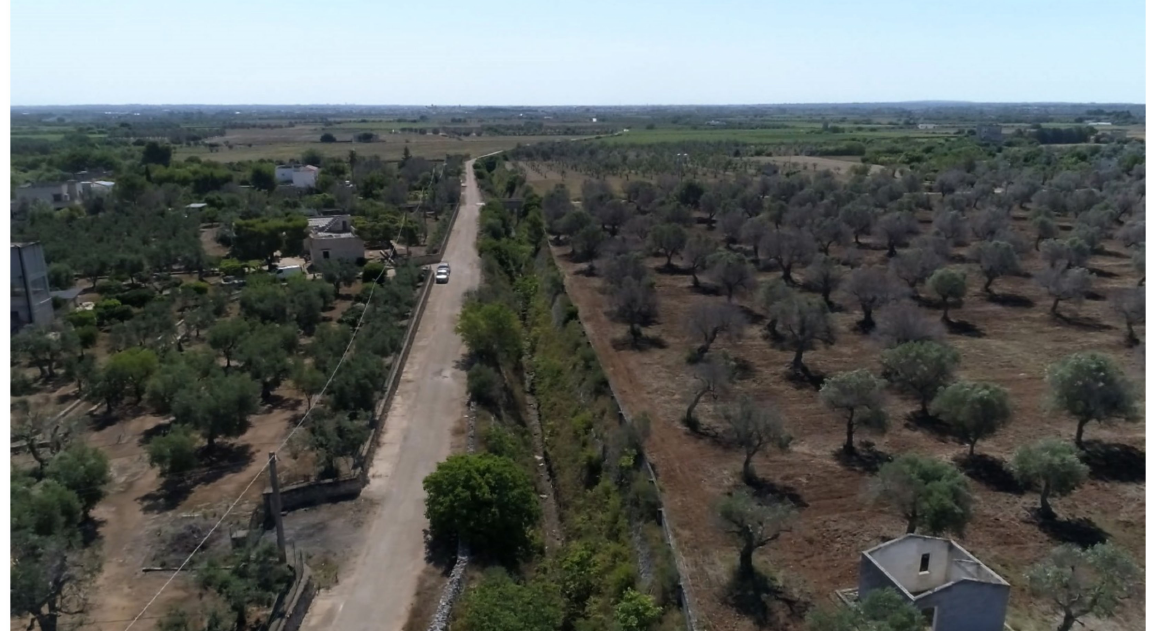
Figure 6. Two olive groves in Nard ò (Lecce province, Apulia, Italy): the trees on the right were abandoned upon the infection by Xylella fastidiosa subsp. pauca , whereas the trees on the left were treated with the zinc–copper–citric acid biocomplex described in [216,217]. The treated trees continue to yield despite the occurrence of the pathogen in the surrounding